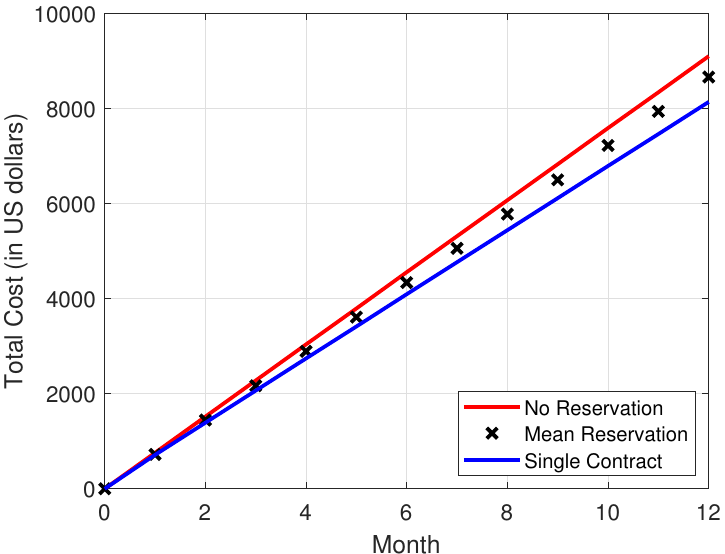
Figure 6. Total cost vs. month. The demand traffic is modeled as an exponential stochastic process with mean = 4000 VMs. Monthly cost (in USD).